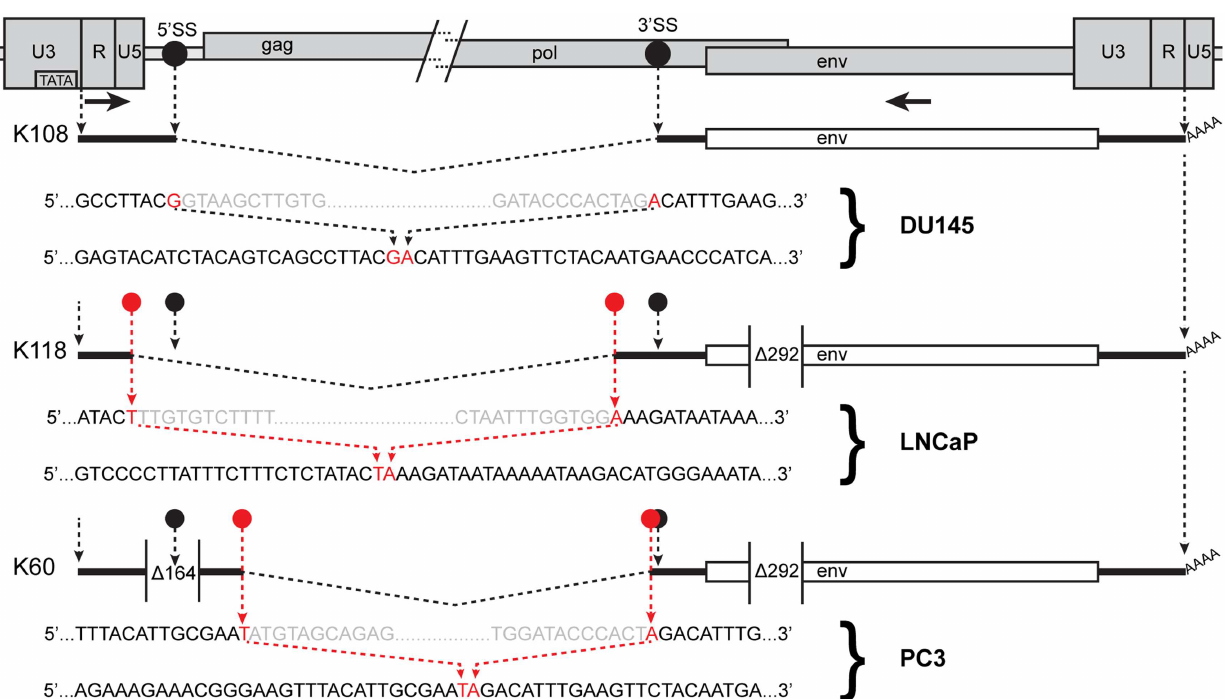
FIGURE 4 | Human endogenous retrovirus K RNA splice sites determined by sequencing of RT-PCR products .The 5 (cid:48) and 3 (cid:48) portions of a HERV-K provirus are shown at the top separated by / and /. 5 (cid:48) SS and 3 (cid:48) SS indicate the conventional splicing sites of HERV-K, and their positions are marked as black circles.The positions of the outer PCR primers used for the nested PCR are shown as arrows. Structures of the env spliced RT-PCR products from the cell lines and proviruses indicated are diagrammed below the viral genome. Dashed angled lines show the excised introns. Red circles show the positions